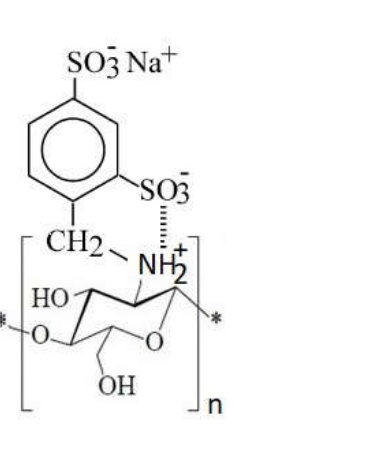
action between the negative sulfate groups and the positive chain of chitosan. Sulfate